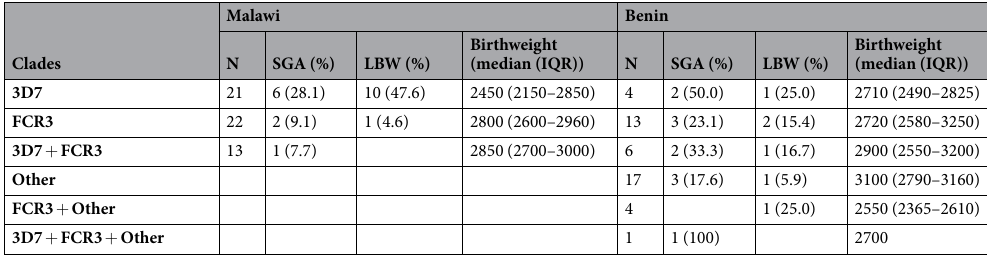
Table 2. Distribution of infant birth weight and adverse birth outcomes by ID1-DBL2x clades in Malawi and